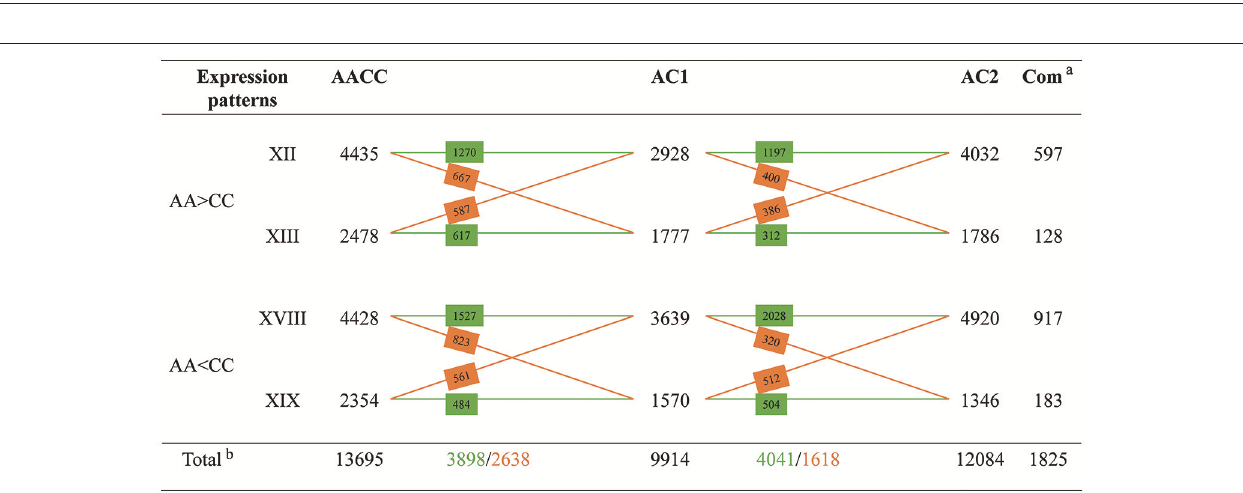
FIGURE 4 | Comparisons of the expression levels of genes showing expression level dominance in AC1. (A) The four expression level dominance patterns, for which the gene expression level in hybrid AC1 is statistically similar to one parent but different from other parent. (B) The normalized expression values, measured in hybrid, the MPV and two progenitors, for genes from the four expression patterns are plotted to illustrate the expression level dominance. The y-axis represents log 2 of the expression level (FPKM). Genes are ordered on the x-axis according to increasing FPKM of their MPV. The number of genes in each comparison is also indicated. Different colors indicate different species as described above, Red, AA1; green, CC; blue, AC1; purple, MPV.